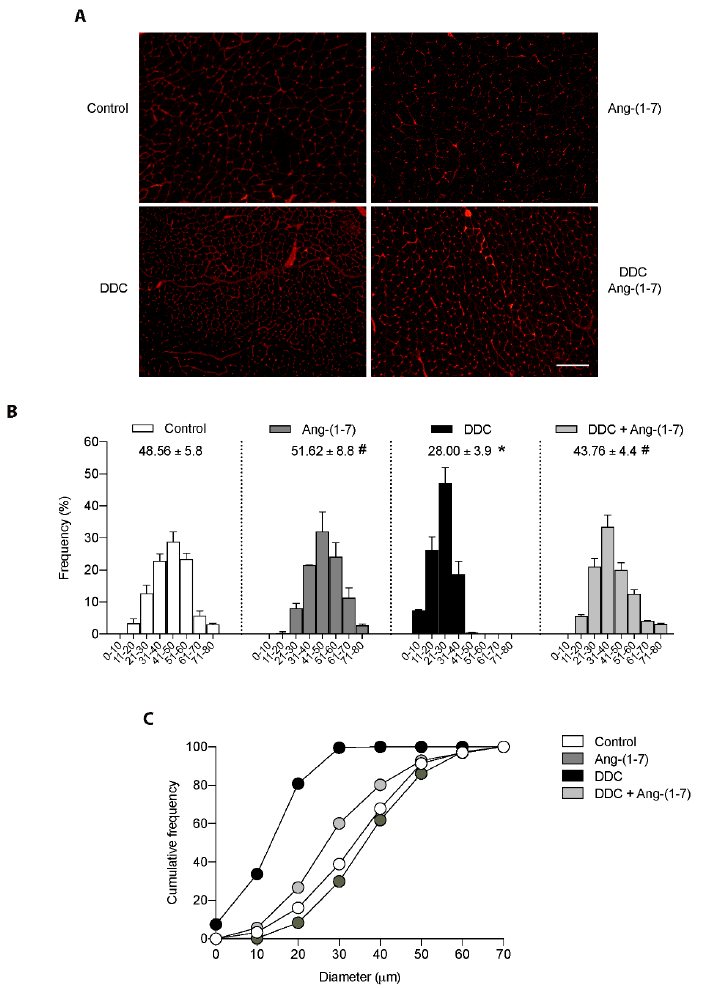
Figure 3. Ang-(1-7) abrogates the diminution of muscle fibers diameter in mice fed with the DDC diet. Male mice C57BL/6J (16 weeks old) were fed with a standard diet (Control) or DDC-supplemented (DDC) for six weeks. Ang-(1-7) was administered for six weeks through osmotic minipumps: The groups were defined as Control, Ang-(1-7), DDC, and DDC + Ang-(1-7). At the end of the experiment, gastrocnemius muscles were excised and frozen. Three independent experiments were performed, using five mice for each experimental condition. ( A ) Cross-sections of gastrocnemius were stained with WGA to delimit muscle fiber sarcolemma. Scale bar: 120 µm. ( B ) Minimal Feret’s diameters were determined in gastrocnemius cross-sections. The values were grouped in ranges from 0 to 80 µm, and frequency per range was plotted as the percentage considering the total amount of quantified fibers. The mean of the diameter per condition is shown. (* p < 0.05 vs. Control; # p < vs. DDC. One-way ANOVA, Tukey’s multiple comparisons test). ( C ) The data was also represented as a cumulative frequency plot according to the diameter range.